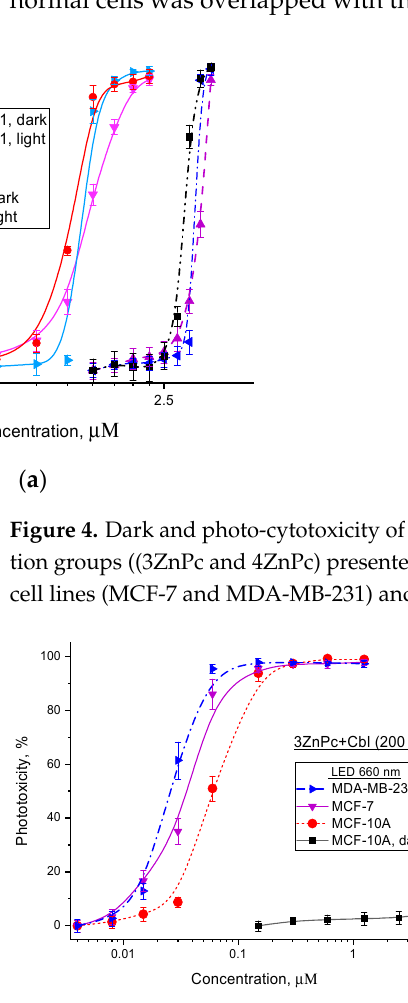
Figure 5. Photocytotoxicity of non-peripherally substituted zinc(II) phthalocyanine (3ZnPc) by addition of 200 µ M cobalamin (Cbl) on breast cancer cell lines MCF-7 and MDA-MB-231 in comparison to a non-tumorigenic MCF-10A cell line. Table 1. Mean values of CC 50 ± SD ( µ M) for cell cultures treated with 3ZnPc and with two compounds (3ZnPc and Cbl).